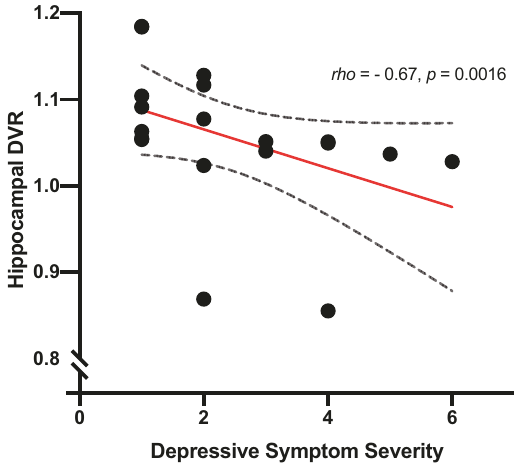
Fig. 5 Relationship of tracer uptake in the hippocampus, as measured by DVR, and depression symptom severity. Dashed line represents 95%